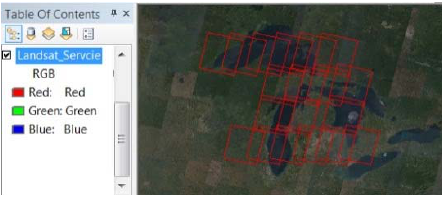
Figure 10. Search result from an image service served by a mosaic dataset